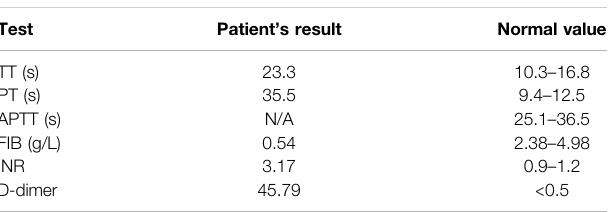
TABLE 1 | Coagulation